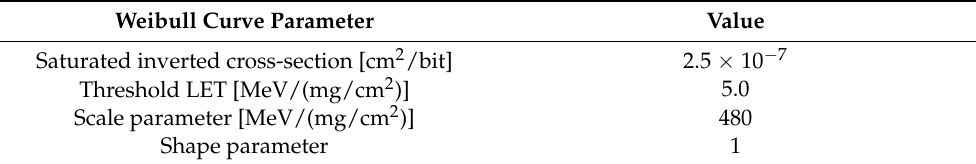
Figure 9. LET–SEU upset cross-section characteristic curve (wireless module: CC1120). Table 7. SEU Weibull curve parameters.